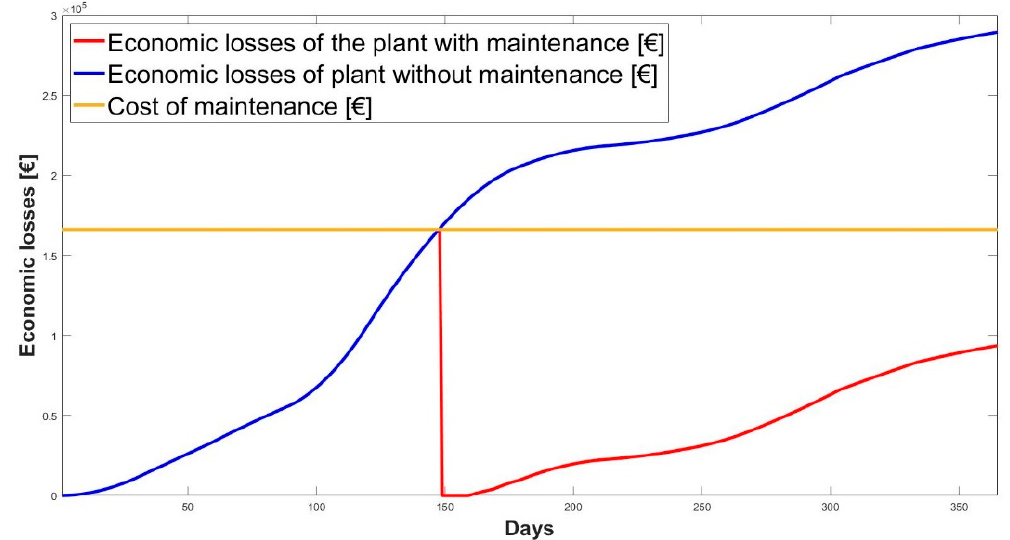
Figure 22. Optimal cleaning interval for the 50 MWp plant from an economic standpoint.